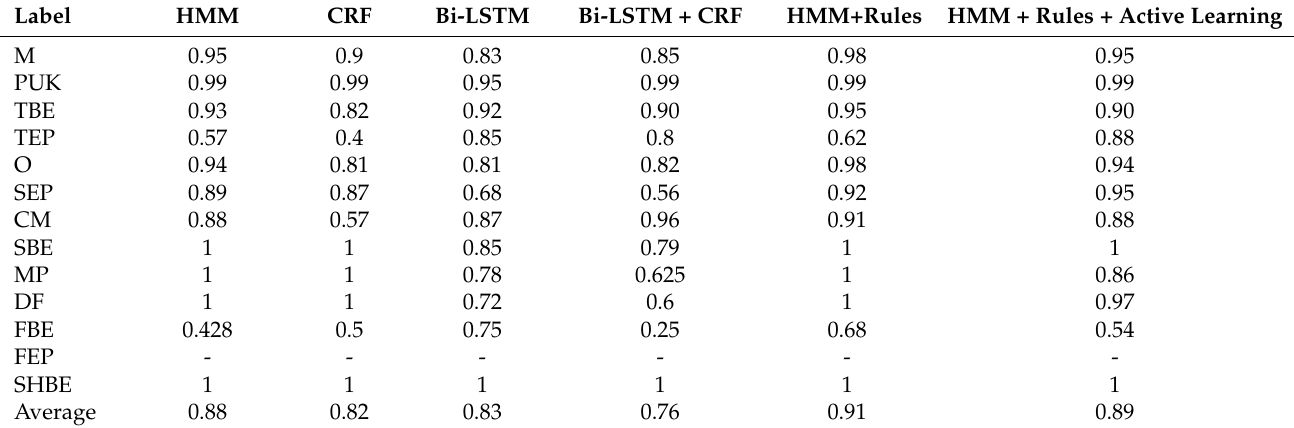
Table 4. F1 scores of four NER algorithms and combined algorithms.